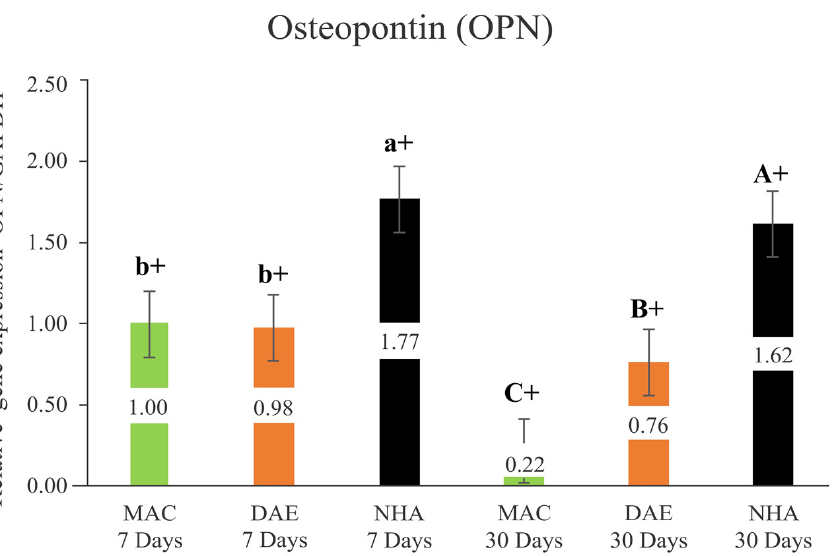
Figure 6. Relative expression of Osteopontin/GAPDH (Opn/GAPDH) in all groups (mean + 95% confidence interval). Lower case letters represent the analysis of 7 days, and capital letters the analysis of 30 days. Different letters indicate a statistically significant difference between groups. The + sign indicates a statistically significant difference (MAC: p < 0.001; DAE: p < 0.001; NHA: p = 0.001) for intragroup analyses, considering the same surface treatment and different assessment